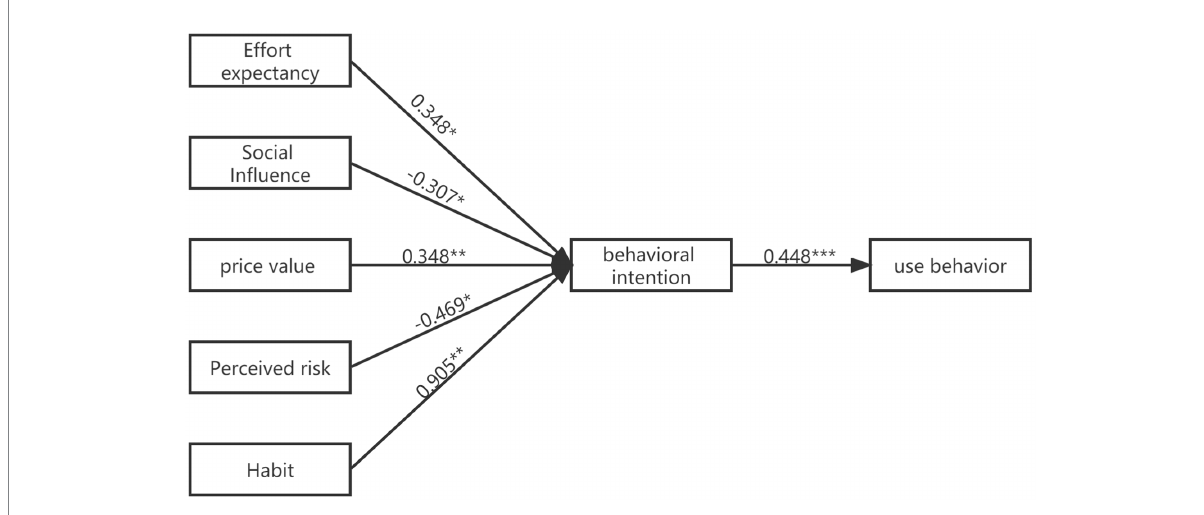
FIGURE 3 Digital academic reading behavior model of college